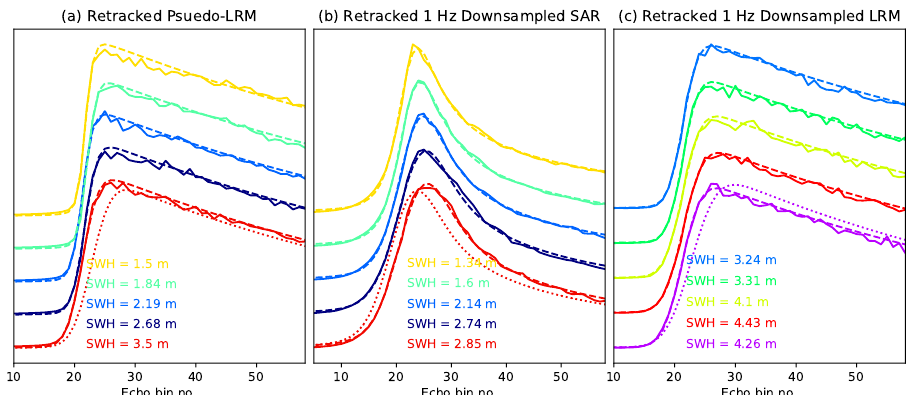
Figure 1. Example power waveform fit for ( a ) pseudo-LRM echoes ( b ) coincident 1 Hz down samples SAR echoes and ( c ) 1 Hz downsamples LRM echoes. Note that plots a and b originate from the same level 1 SAR retrievals. Each waveform (solid line) is plotted alongside an optimised 3 parameter fitted semi-analytic wave (dashed line) with the associated SWH listed . All waves are normalised by peak power and plotted at increasing height for clarity. The bottom most wave also has a 1 parameter (SWH only) matched wave plotted alongside (dotted line). The location of each wave is plotted in the same colors in Figure 2.